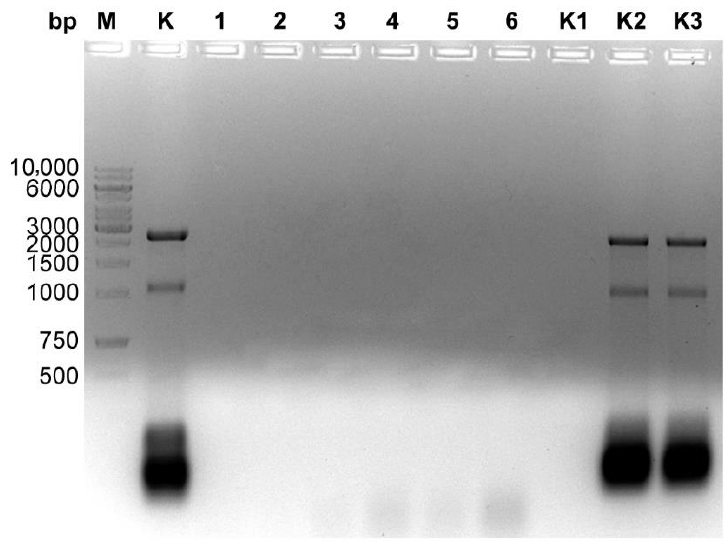
Figure 3. Digestion of E. coli RNA with RNase A in different concentration of CsCl. A total of 7 µg of E. coli RNA was digested with 3.5 µg RNase A at 37 °C for 30 min. RNase-digested RNA was purified using a RNA Clean-Up kit. A total of 1.2% agarose gel electrophoresis: Lane M, GeneRuler 1 kb DNA Ladder; lane K, undigested E. coli RNA (7 µg); lanes 1 – 6, samples with CsCl diluted 1:10, 1:9, 1:8, 1:7, 1:6 and 1:5; lane K1, a sample without CsCl; lane K2, sample without RNase A and CsCl;